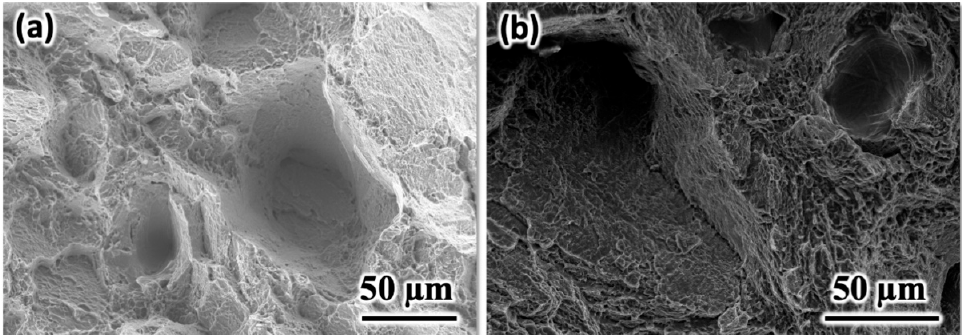
Figure 5. Secondary electron fractographic micrographs demonstrating the presence of large pockets in the ( a , b ) vertically built ASR-C1, Ti-6Al-4V ELI alloy sample.